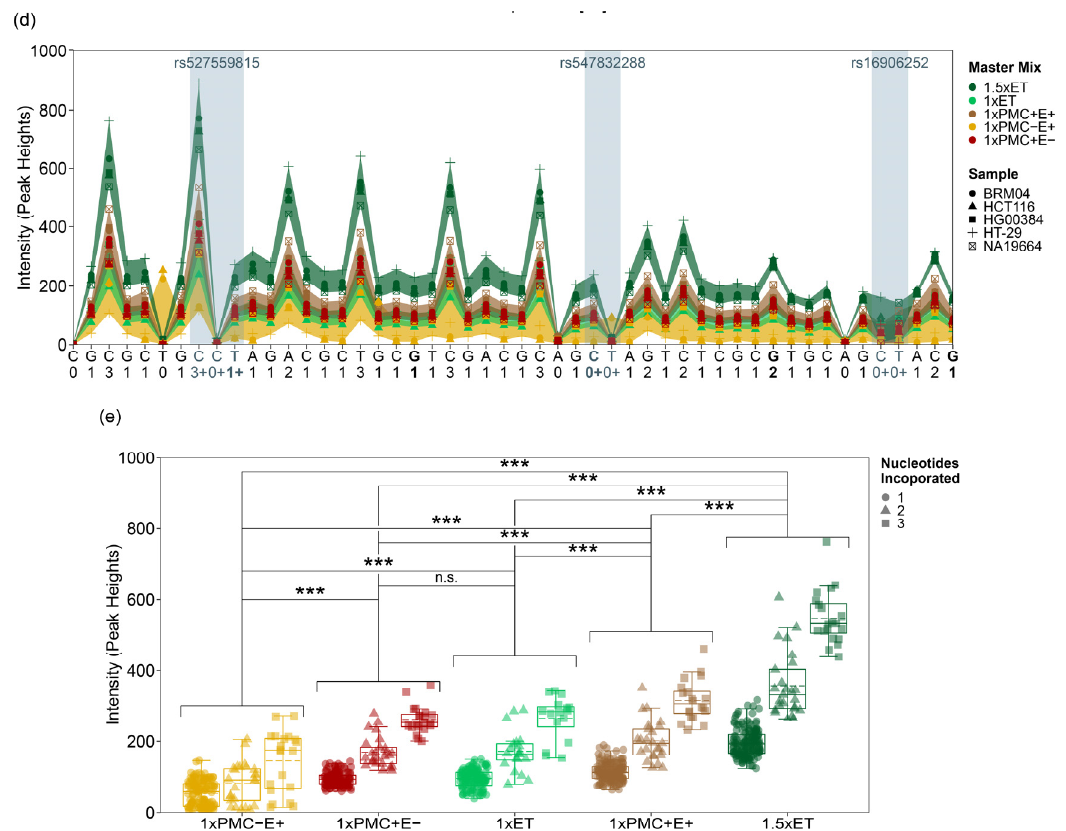
Figure 2. Testing the suitability of different master mixes using the 3 SNPs assay for ( a – c ) HRM analysis and ( d , e ) PSQ. Five samples, which were homozygous C for rs527559815 and rs547832288 and either homozygous C (HT-29), T (NA19664), or heterozygous (HG00384, HCT116, BRM04) for rs16906252, were selected. PyroMark PCR Master Mix (PM) with (+) or without ( − ) CoralLoad Concentrate (C) and EvaGreen dye (E) as well as EpiTect HRM Master Mix (ET) were used. ( a ) raw melting curves, ( b ) normalized melting curves (normalization range 1: 72.80–74.30 ◦ C, normalization range 2: 92.50–94.00 ◦ C) and ( c ) derivative normalized melting curves obtained by Savitzky-Golay filtering. PMC+E+ (brown), PMC − E+ (ocher) and ET (green). ( d ) Peak heights obtained from PSQ were plotted against the dispensation order and number of nucleotides incorporated; every tenth dispensation is marked in bold. Either 15 µ L PCR product per 80 µ L immobilization reaction (1 × ) or 22.5 µ L PCR product per 120 µ L immobilization reaction (1.5 × ) were used. Variable positions (additional variable nucleotide incorporation: (+)) are highlighted in blue gray. For each dispensation, the range from the lowest to the highest intensity per master mix is shaded. ( e ) Statistical comparison of peak heights between different master mixes grouped by the number of nucleotides (nts) incorporated per dispensation (1–3 fold). Variable positions were excluded; solid line represents the median, dashed line the mean and significance is marked with *** for p ≤ 0.001 and n.s. for not significant. All data shown originate from one and the same PCR-HRM run. For clarity reasons, the melting curve of one PCR replicate is